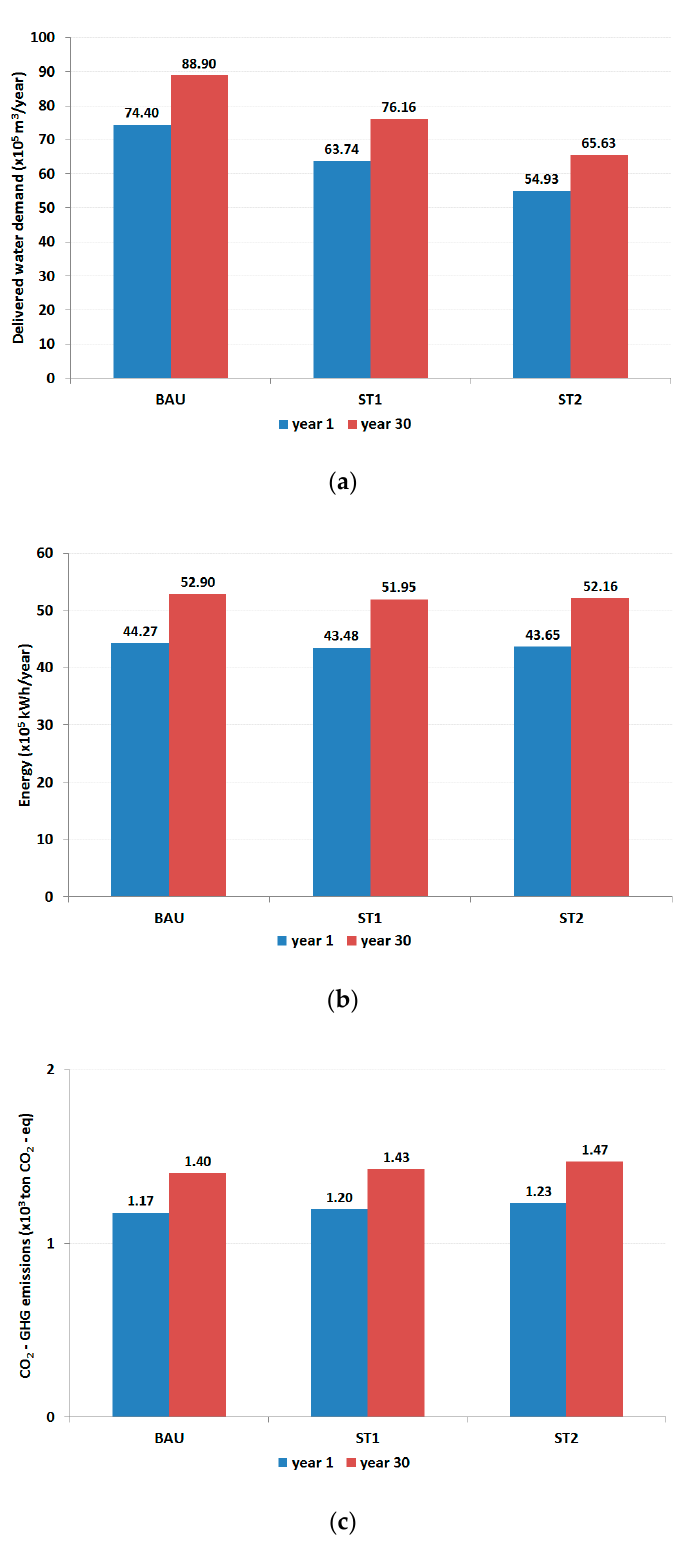
Figure 13. ( a ) Delivered water demand (m 3 /year) from the Roncocesi well field for the first and last simulation year and for the three alternative configurations (BAU, ST1, ST2); ( b ) same as (a) but referred to the total energy (kWh) consumed by the UWS; ( c ) same as (a) but referred to CO 2 emissions (ton CO 2 -eq) produced by the UWS.